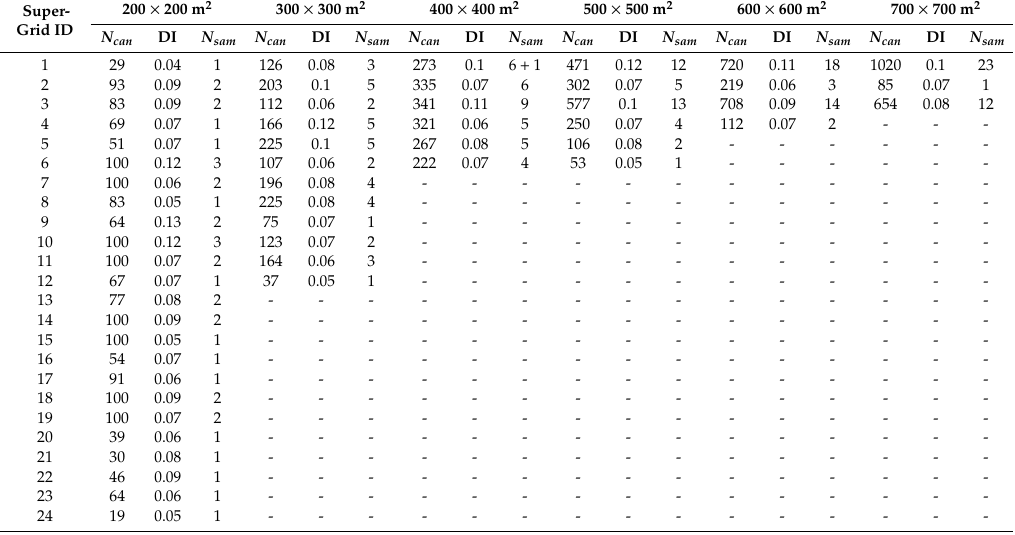
Table 3. The numbers of candidate sampling points ( N can ), the diversity indexes (DIs), and the numbers of sampling points ( N sam ) for the super-grids ranging from 200 × 200 m 2 to 700 × 700 m 2